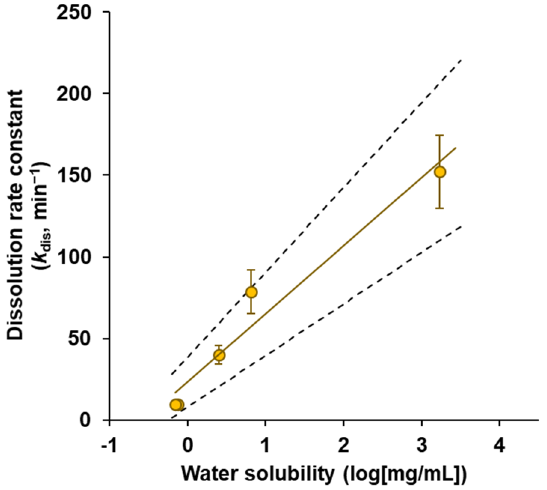
Figure 3. Correlation between the dissolution rate constant ( k dis ) and the water solubility for five model drugs, antipyrine, salicylic acid, norfloxacin, acyclovir, and sulfanilic acid. A statistically significant linear correlation was obtained ( r 2 = 0.956, p = 0.0028). The dashed lines indicate the 95% confidence interval for the fitted line. The data are represented as the mean of independent experiments, with the vertical bars indicating the S.E. (n = 3–5).